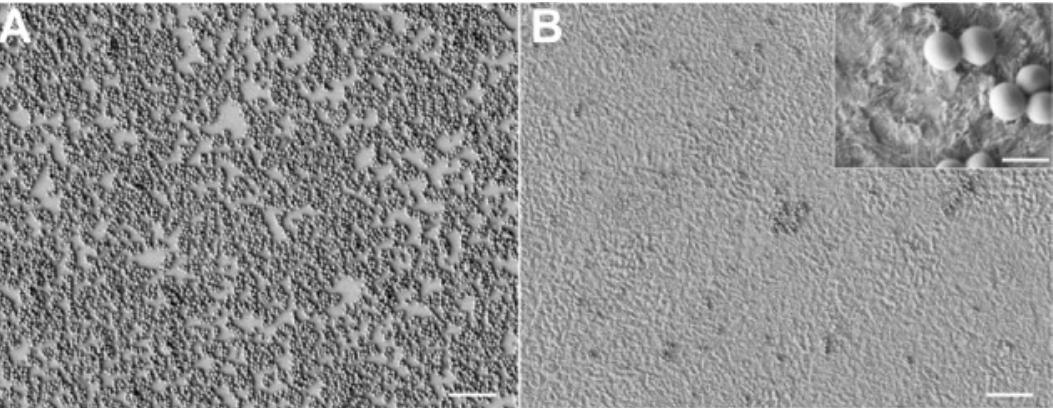
Figure 2. Image obtained during clinical practice of Dr. L. Fiorillo. Radiographic examination of implant with peri ‐ implantitis due to the formation and organization of a biofilm on the implant surface. The interface between the bone tissue and the implant has been interrupted, this must be minimal and in the absence of biofilm to guarantee integration.